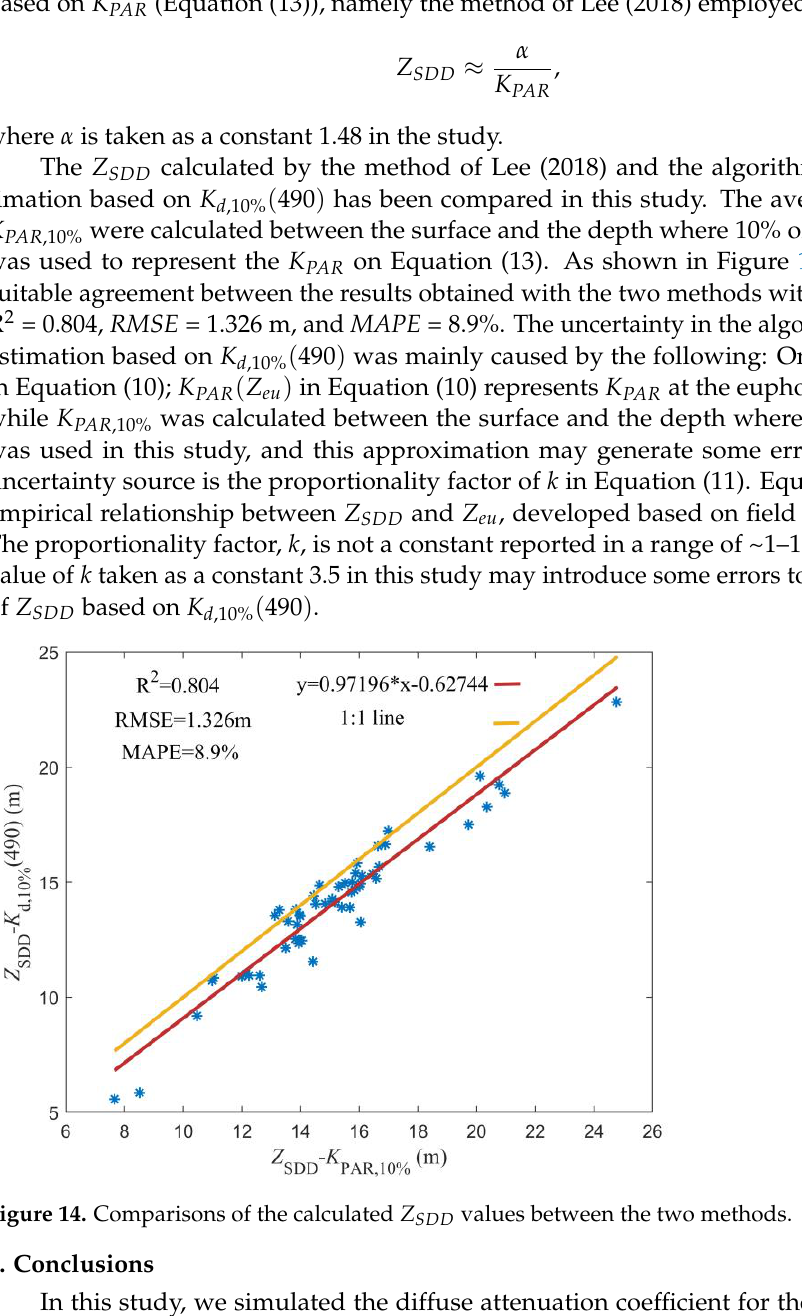
SDD values between the two